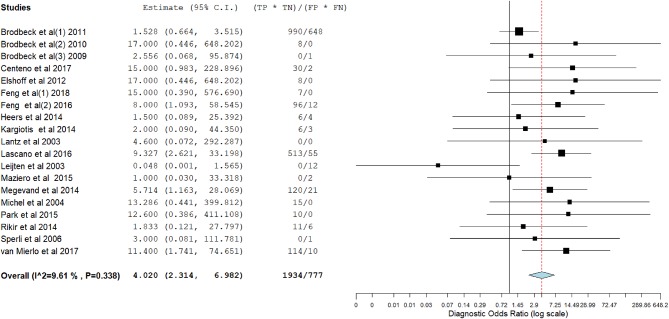
Forest plot showing diagnostic odds ratio of the II-ESI studies (individual studies: size of the squares are proportional to weights used in meta-analysis; the summary measure: center line of the diamond; associated 95% confidence intervals: lateral tips of the squares and the diamond).